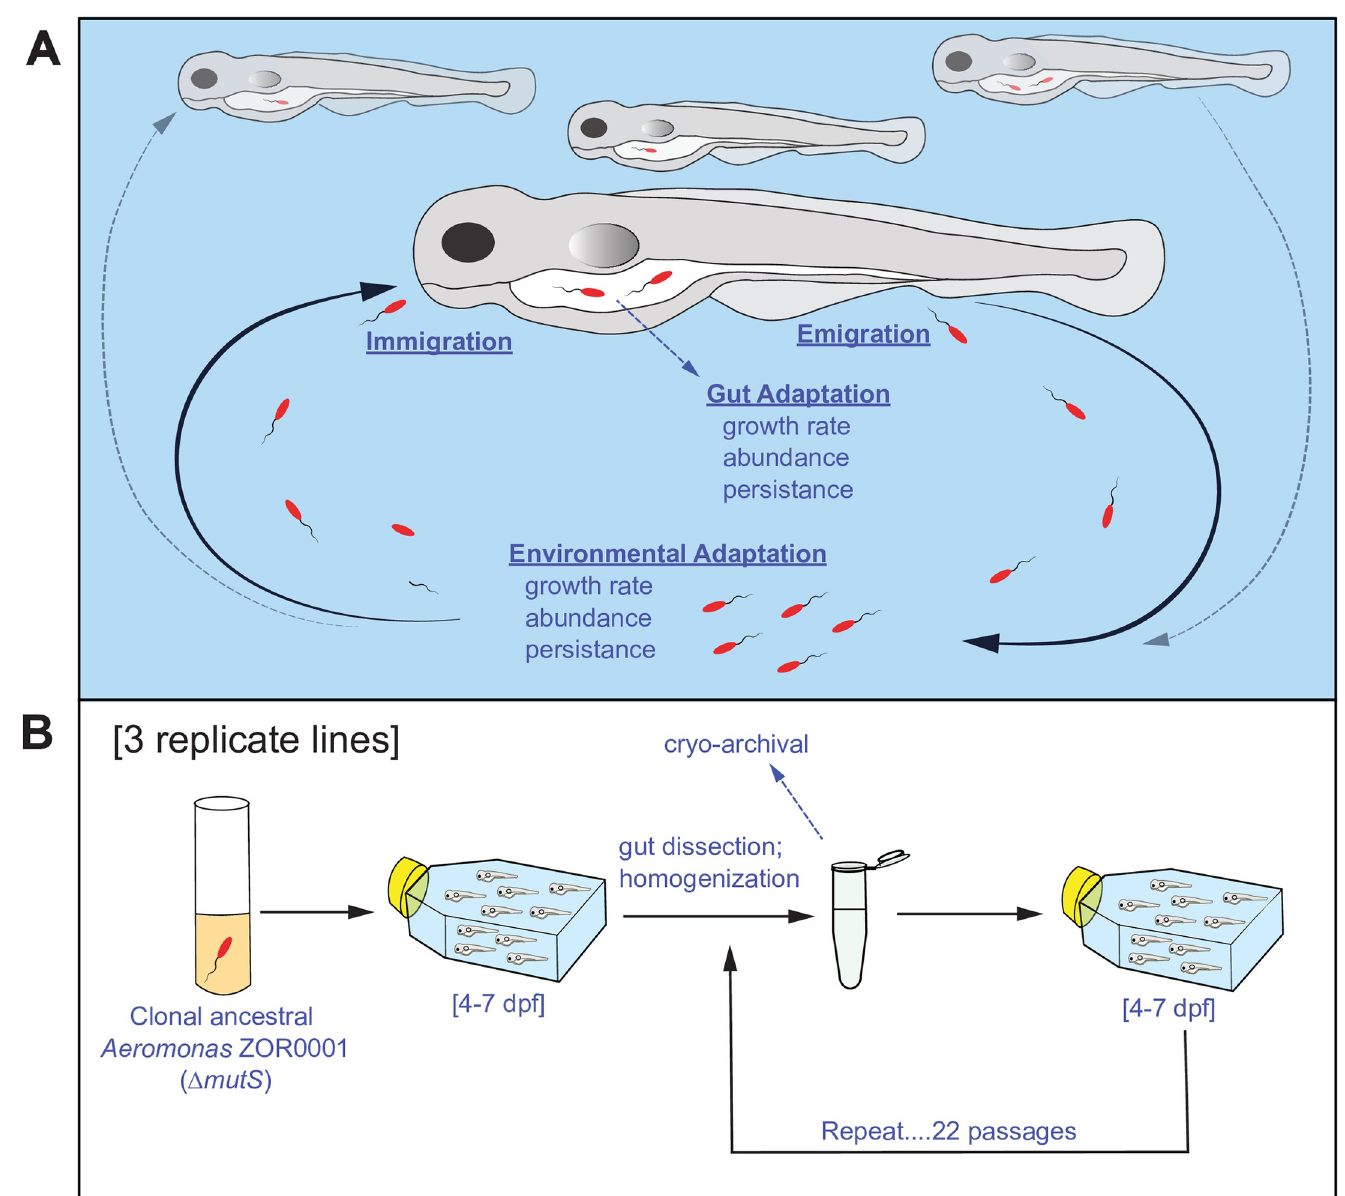
Fig 1. Experimental evolution of Aeromonas ZOR0001 in the larval zebrafish host. (A) Conceptual diagram of the colonization cycle and potential bacterial strategies for adaptation to the zebrafish gut. (B) Passaging scheme of the evolution experiment. dpf, days post fertilization.